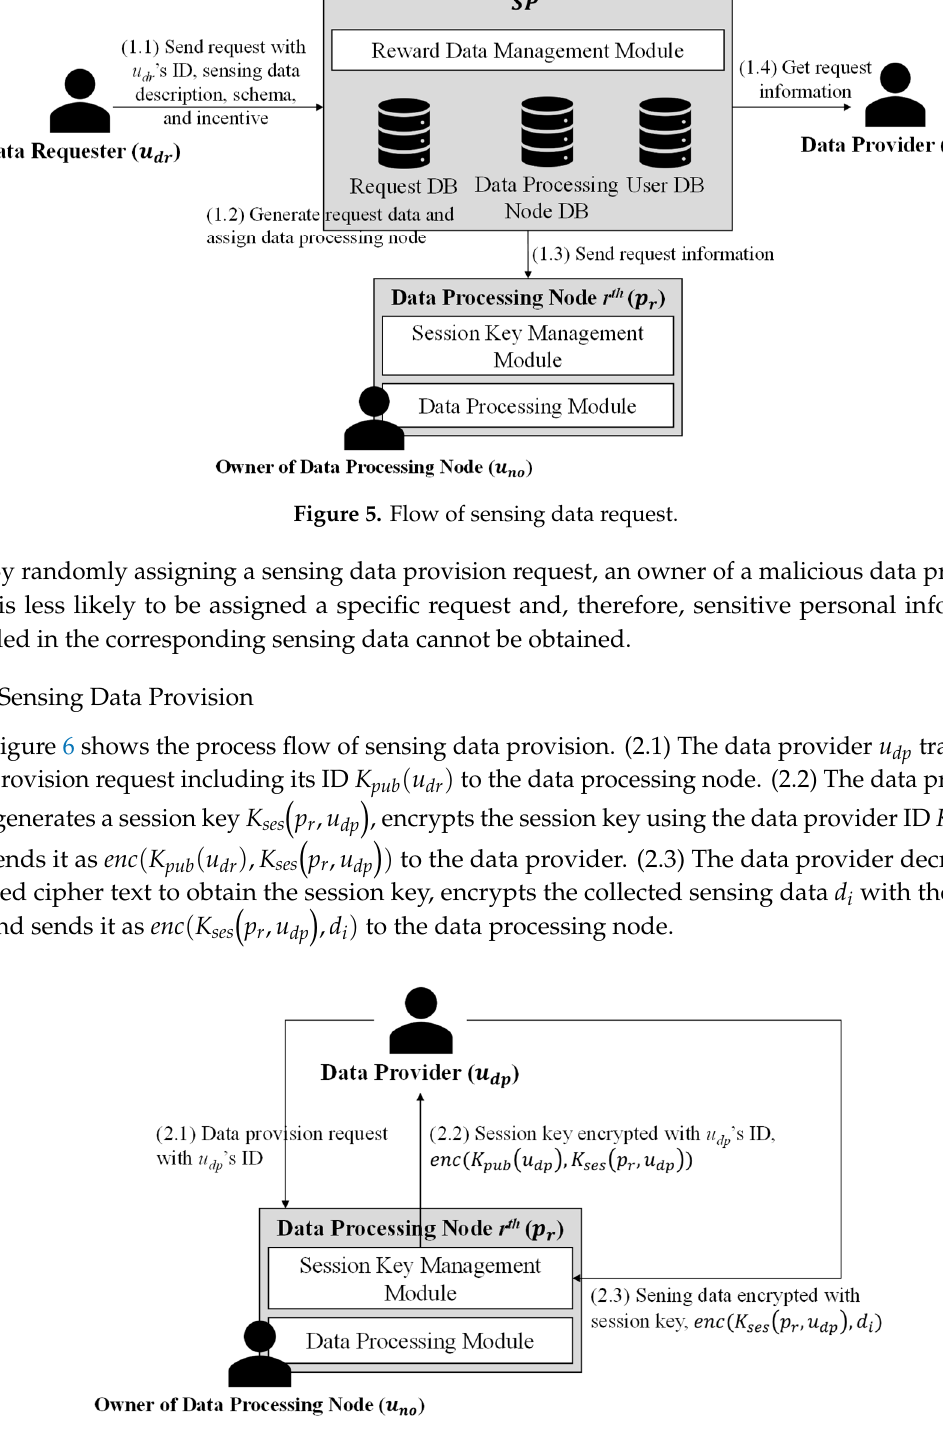
Figure 6. Flow of sensing data provision.